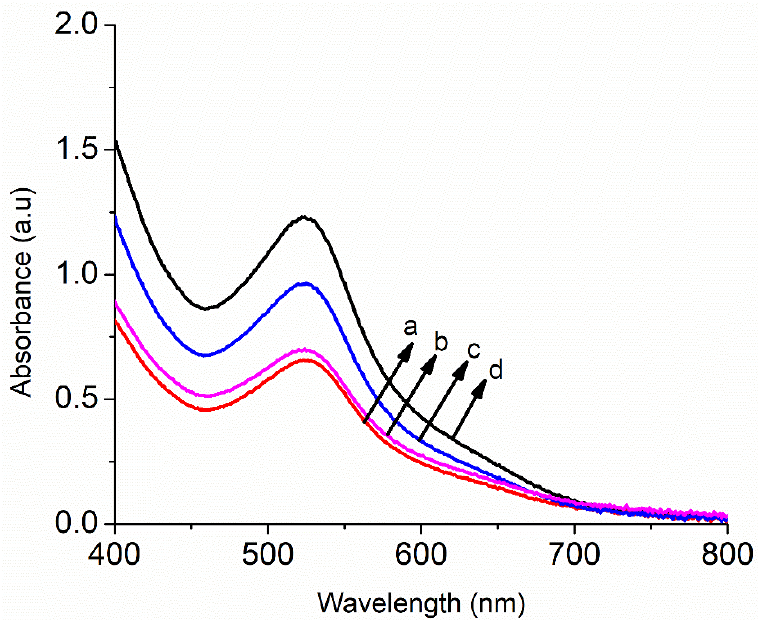
Figure 7. Absorbance spectra of Au (0.0, 0.5, 1.0 and 1.5 wt%)-doped ZnO–Sm nanoparticle films.